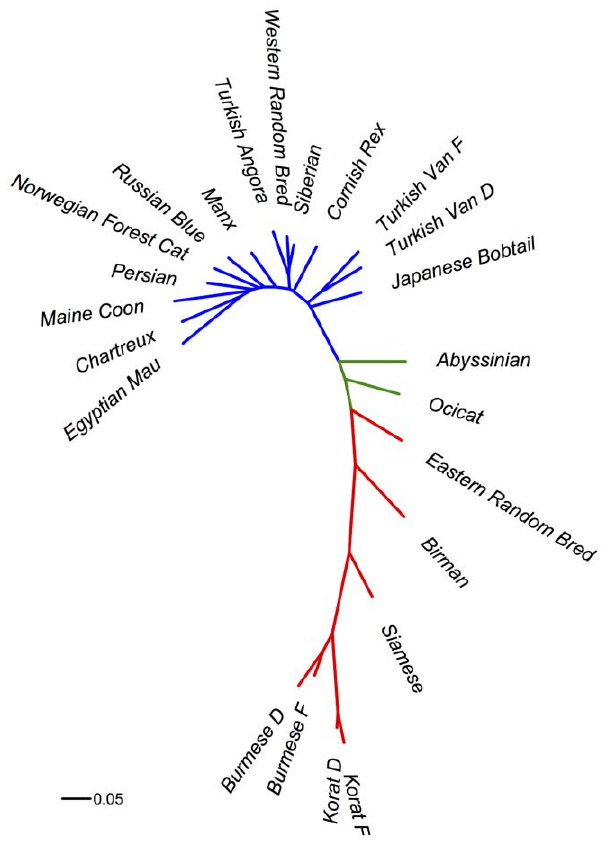
Figure 2. Domestic cat population analysis. F st based neighbor- joining tree of cat populations. Red color represents eastern derived populations, blue represents western derived populations, and green color represents other populations.